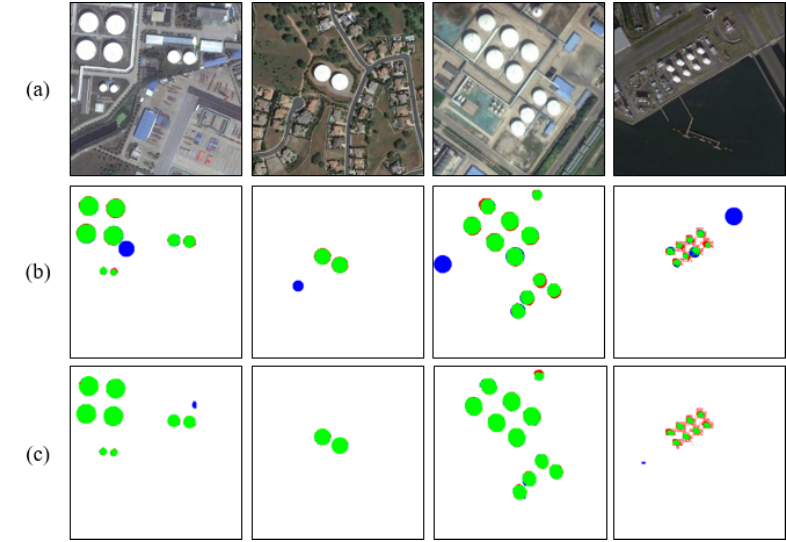
Figure 11. Comparison of two detection methods when similar shapes occur. ( a ) is the input image, ( b ) is the method from Ok, ( c ) is our